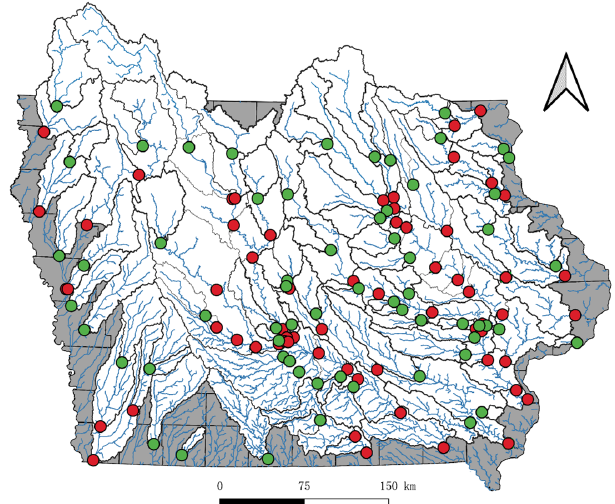
Figure 1. The location of 125 USGS gauges in the State of Iowa for upstream sub-basins (green dot) and large downstream basins (red